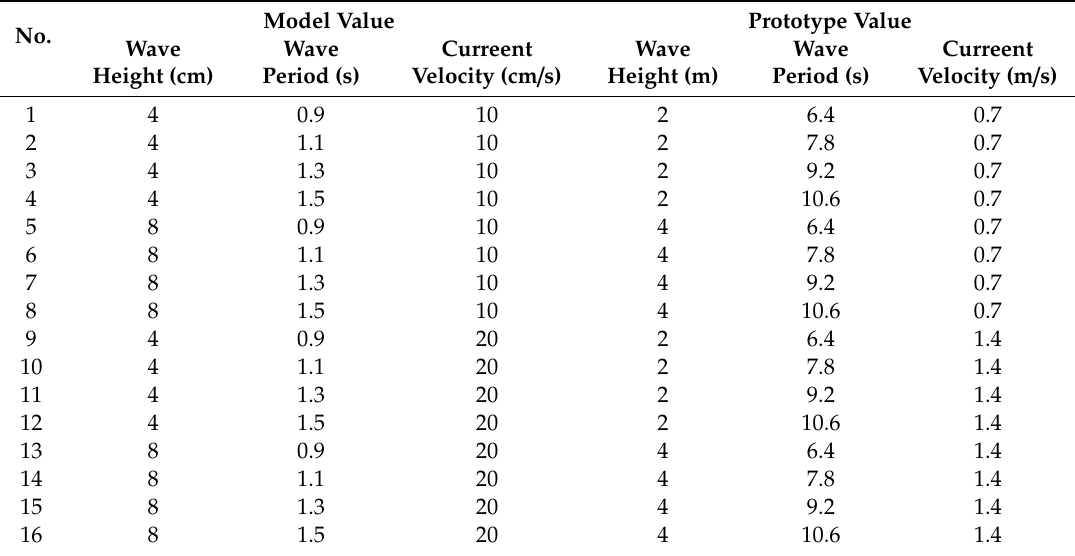
Table 3. Wave conditions for the numerical calculation and the physical